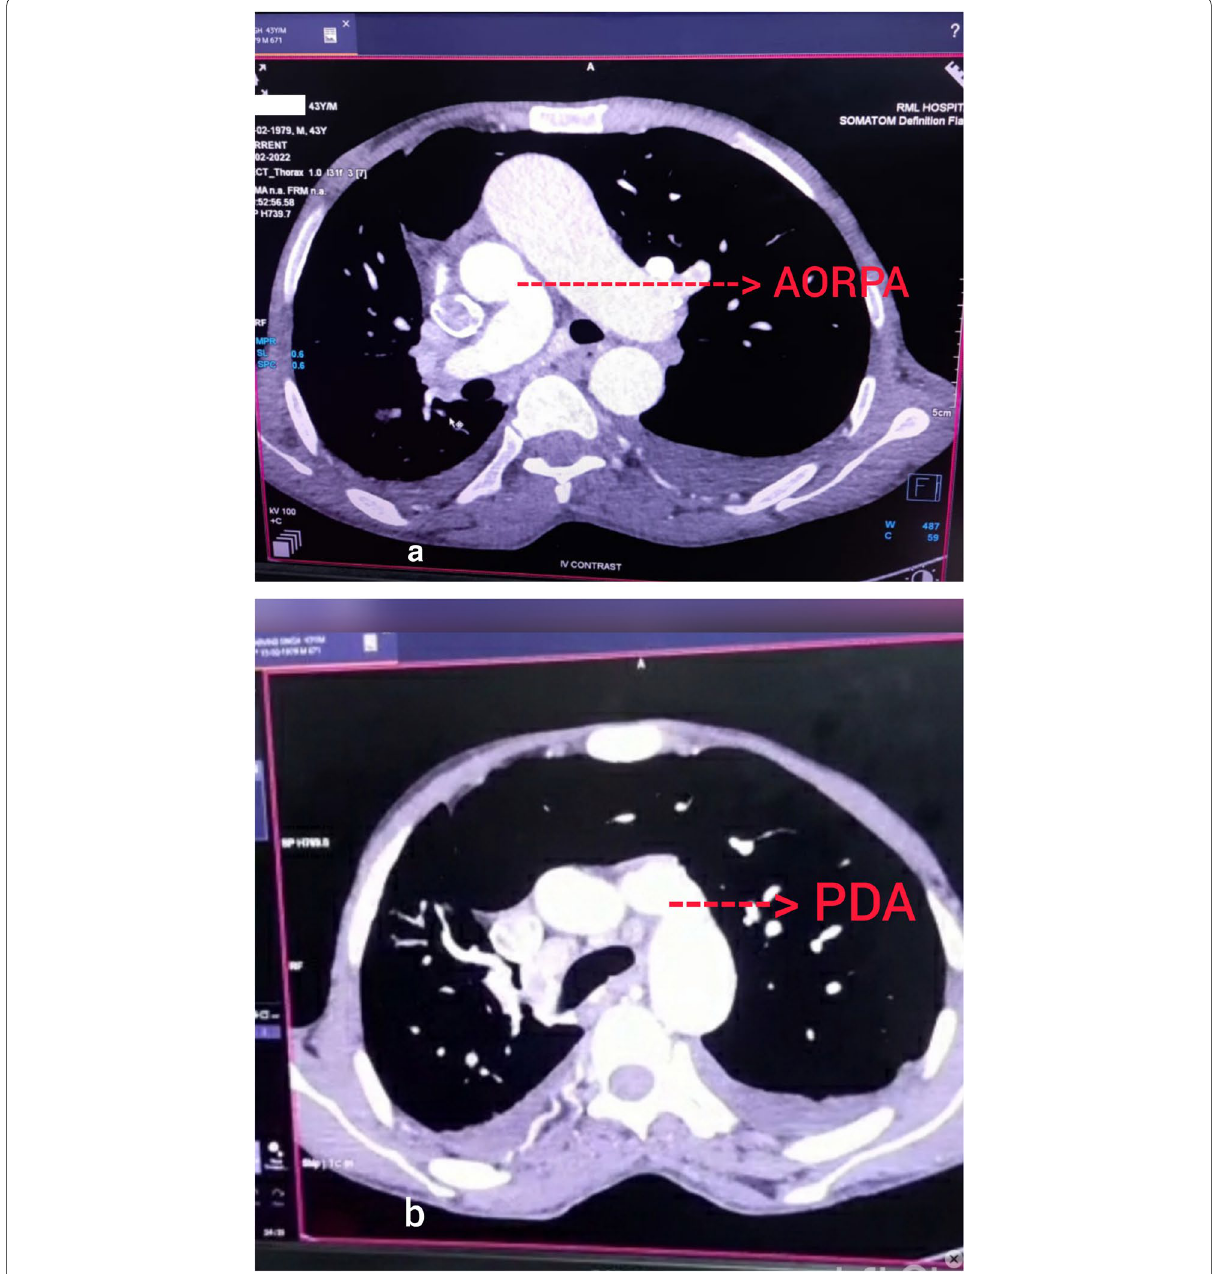
Fig. 3 CT cardiac with pulmonary angiogram. a AORPA b